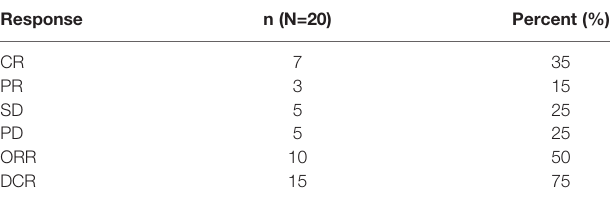
TABLE 2 | Responses to treatment.